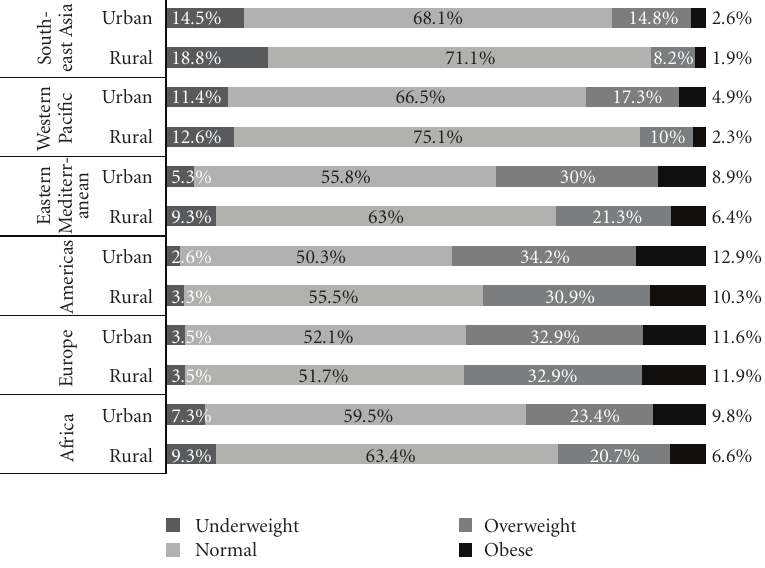
Figure 2: Prevalence of BMI classification by WHO region and urbanicity, WHS,